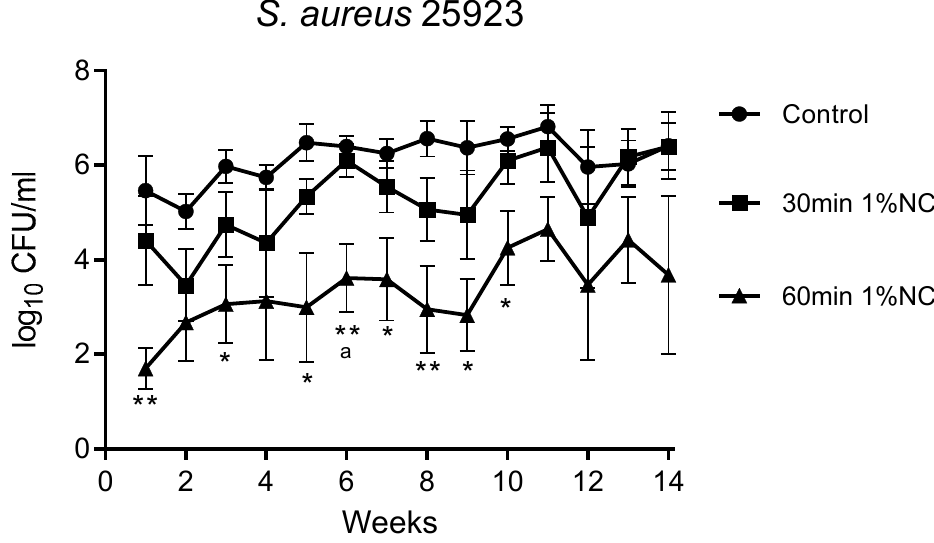
Figure 1. Bactericidal activity of 1% NCT at pH 7 and 37 °C against biofilms of S. aureus ATCC 25923 grown for 14 weeks. Weekly evaluation by quantitative killing assays. Mean values ± SEM, n = 5 ( n = 3 for weeks 12–14); * p < 0.05 versus control; ** p < 0.01 versus control; a p < 0.01 between 30 and 60 min NCT.